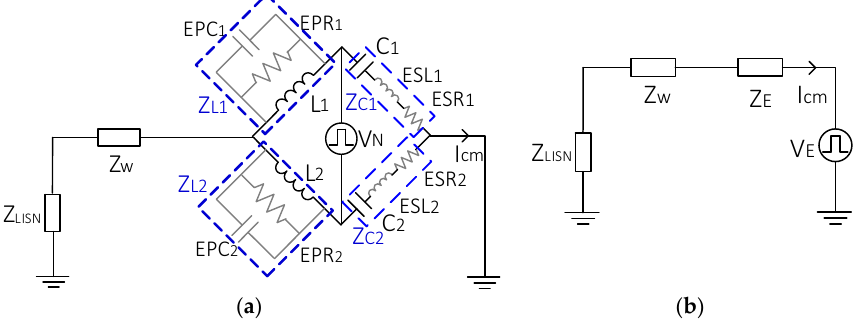
Figure 9. ( a ) CM noise model of the impedance balanced boost circuit; ( b ) simplified CM noise model by the Thevenin theorem.